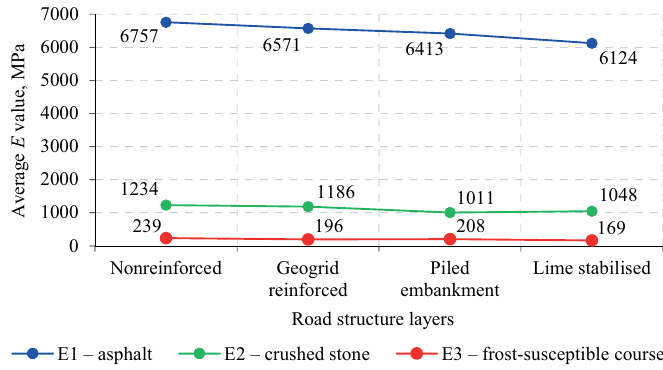
Figure 10. Average values of bearing capacity in the national road No. 131 (44.80–50.80 km)